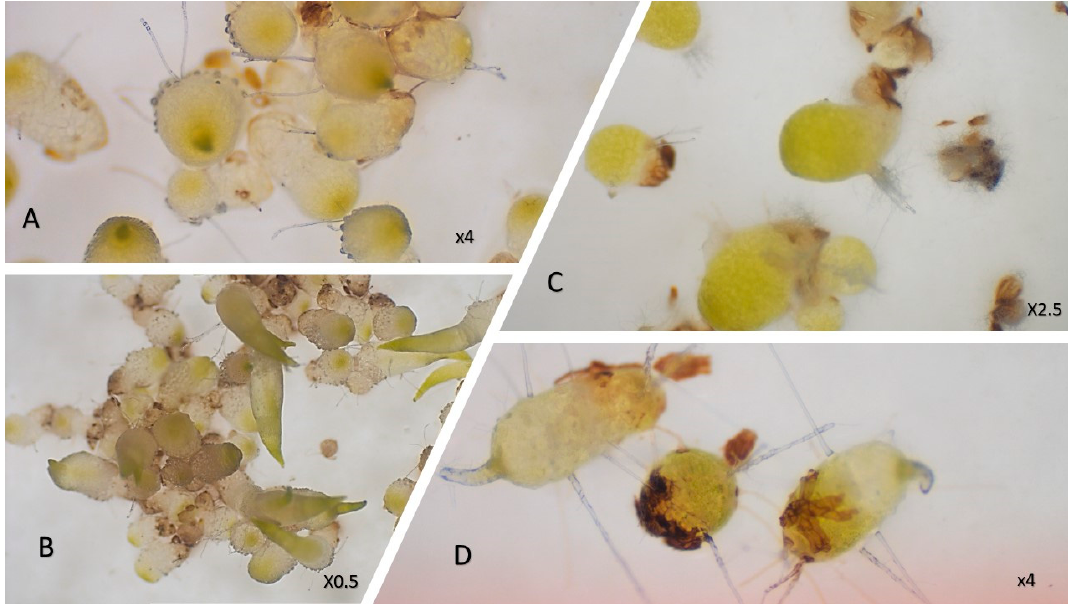
Figure 4. Symbiotic seed germination in vitro of Bulbophyllum peyrotii ( A , B ), Angarecum rutenbergianum ( C ), and Tylostigma nigrescens ( D ).